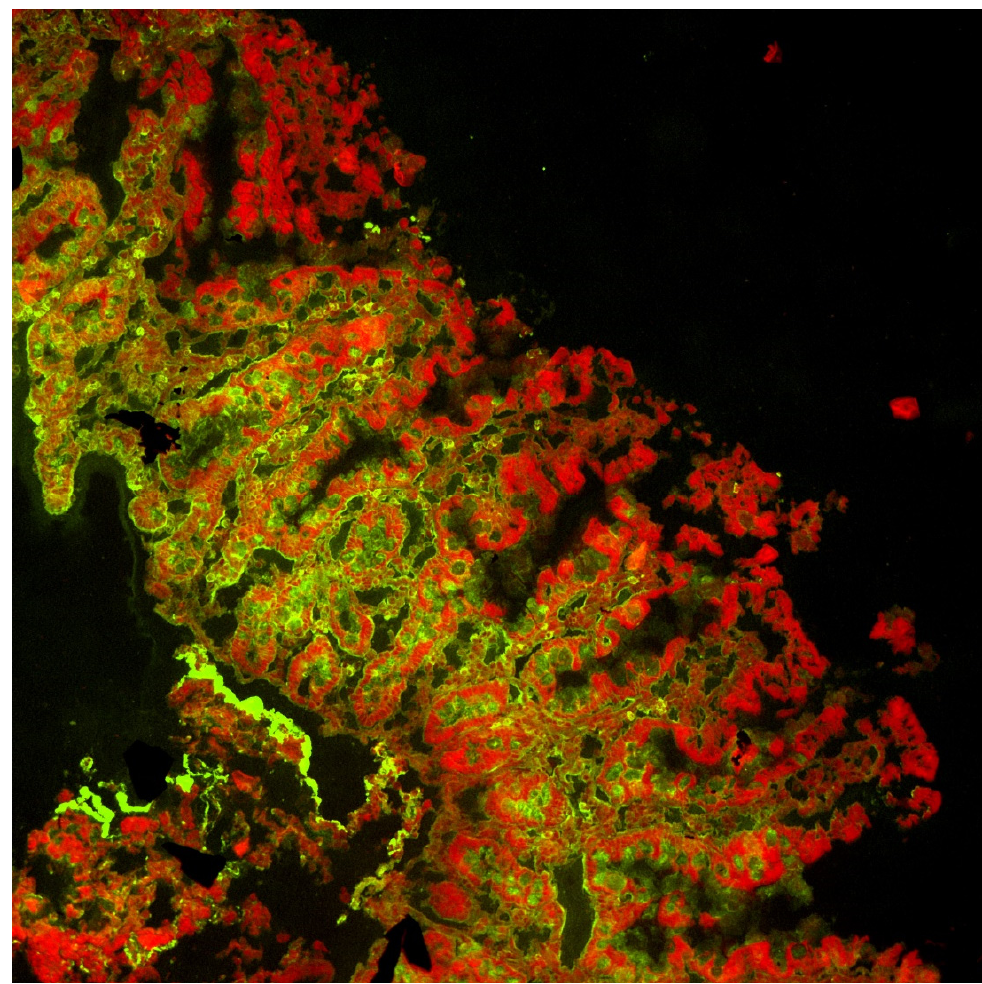
Figure 5. Deposition of IgA is shown in green, and deposition of TG2 is shown in red. Database Storing and CDSS Performances